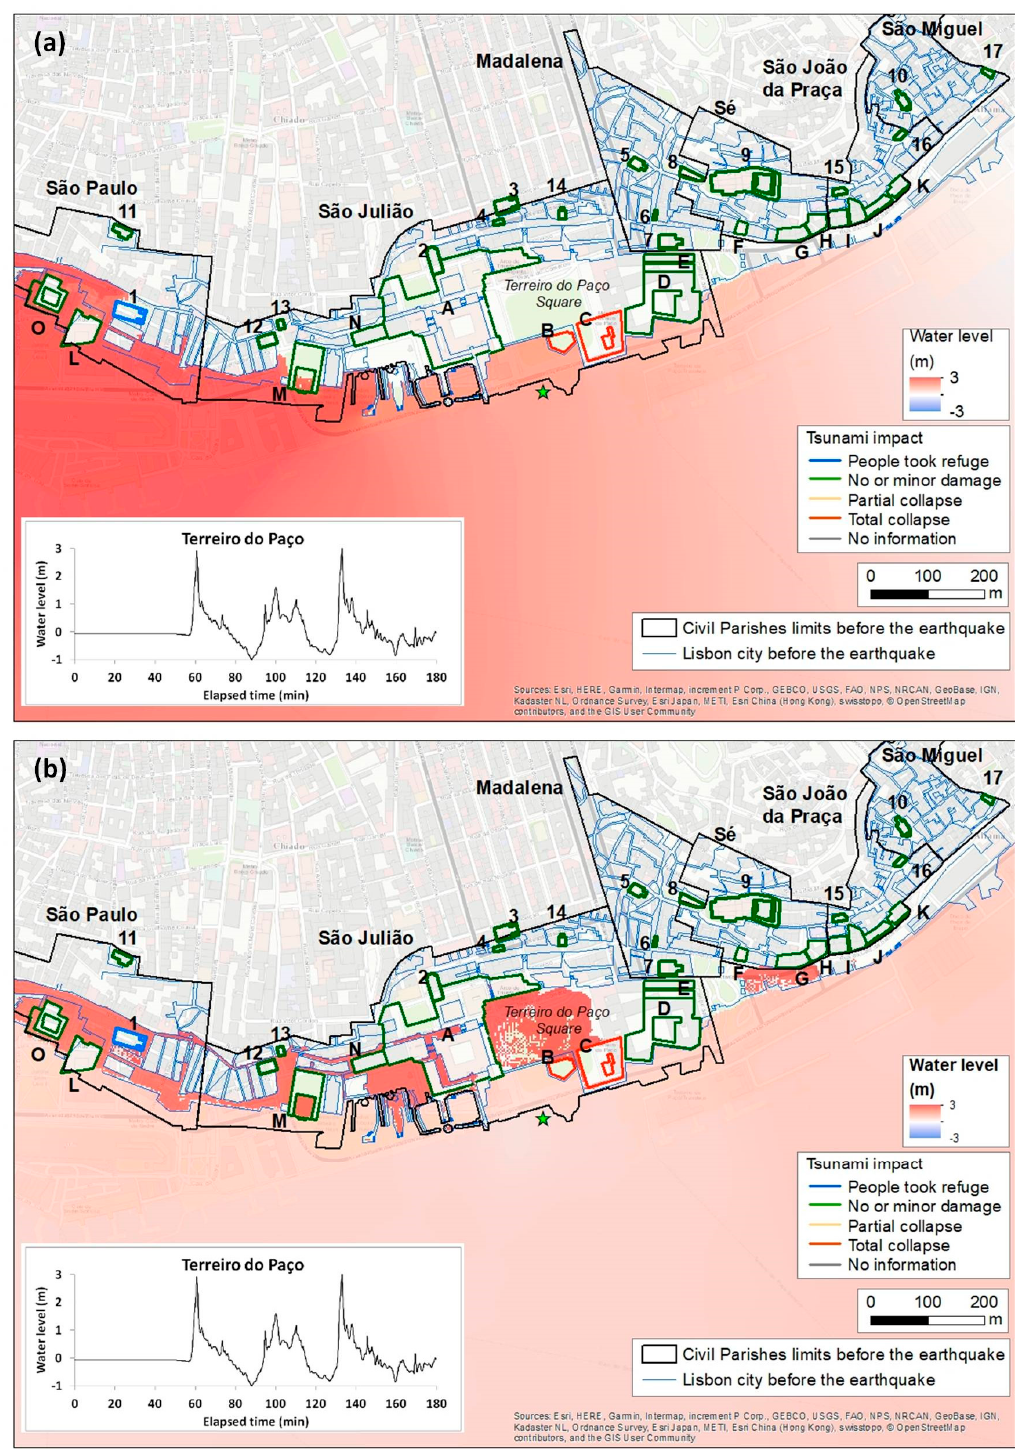
Figure 15. Numerical model results: ( a ) arrival of the first wave at 60 minutes; ( b ) first wave inundates most parts of the river frontside at 65 minutes; the embedded graphic showed the water level history in the first three hours after the earthquake at Terreiro do Paço (location of the virtual tide gauge indicated with a green star). The list of churches and buildings is given in the caption of Figure 10. Another model output is the inundation depth, presented in Figure 16. The results show the tsunami inundated almost all the lower ground area of the downtown Lisbon coastline. The